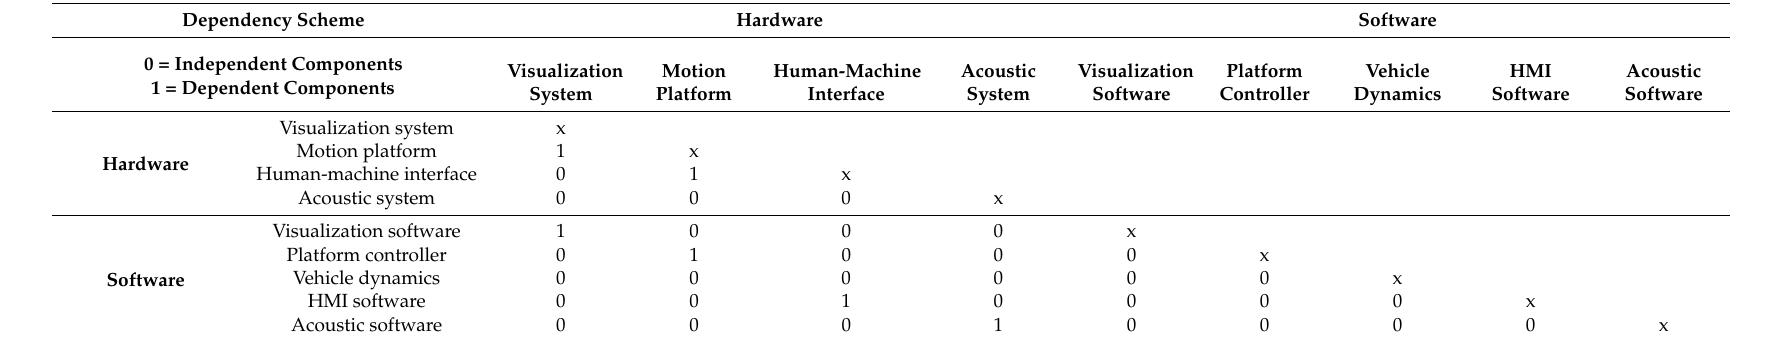
Table 4. Dependency matrix of driving simulator components